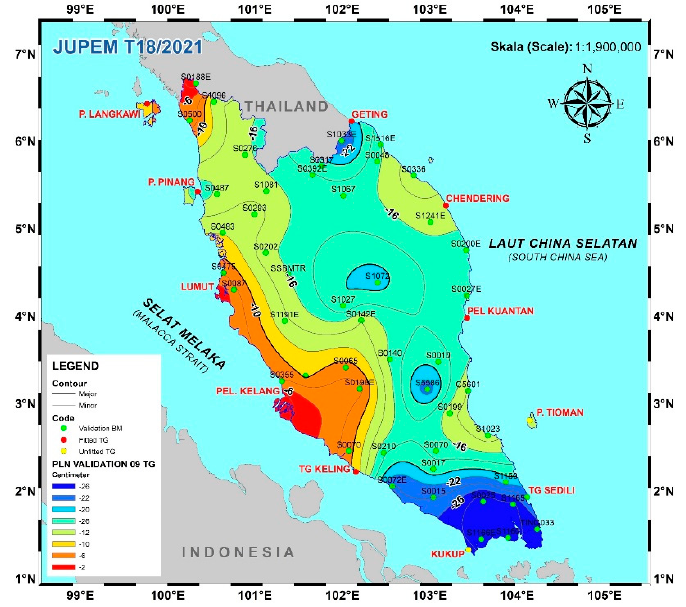
Figure 17. Gridded correction ( ∆ H) for the transformation from PMGVD2000 to PMGVD2022 based on 45 Precise Levelling Network (PLN) benchmarks (CI = 2 cm) ( H PMGVD2022 = H PMGVD2000 + ∆ H).